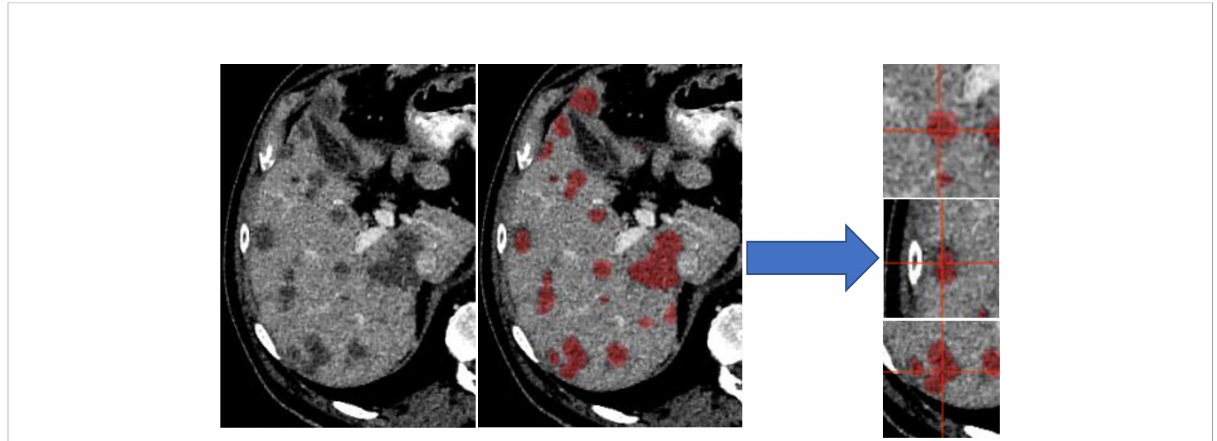
FIGURE 1 Liver distributed into individual slabs of 32 × 120 × 120. Disease was labeled as disease, regardless of the center of the slab. The validation and test set were not broken into slabs; our architectures accepted variable input sizes, with the entire liver being passed at once for evaluation and testing.